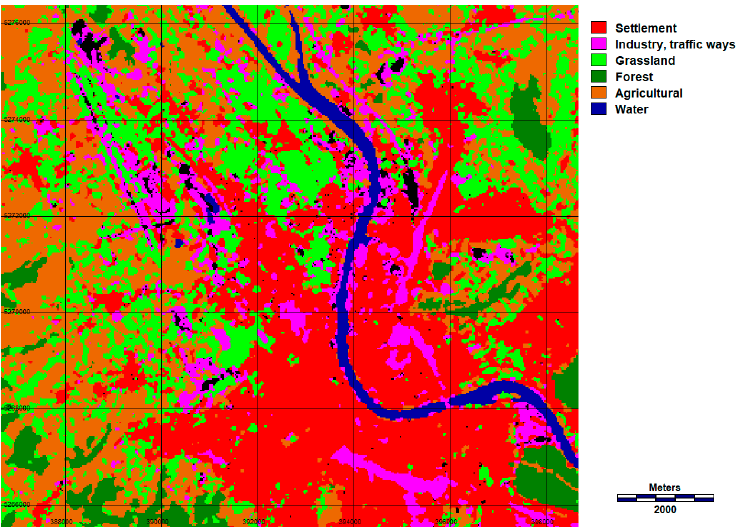
Figure 6. Landuse/landcover (LULC) in Basel.